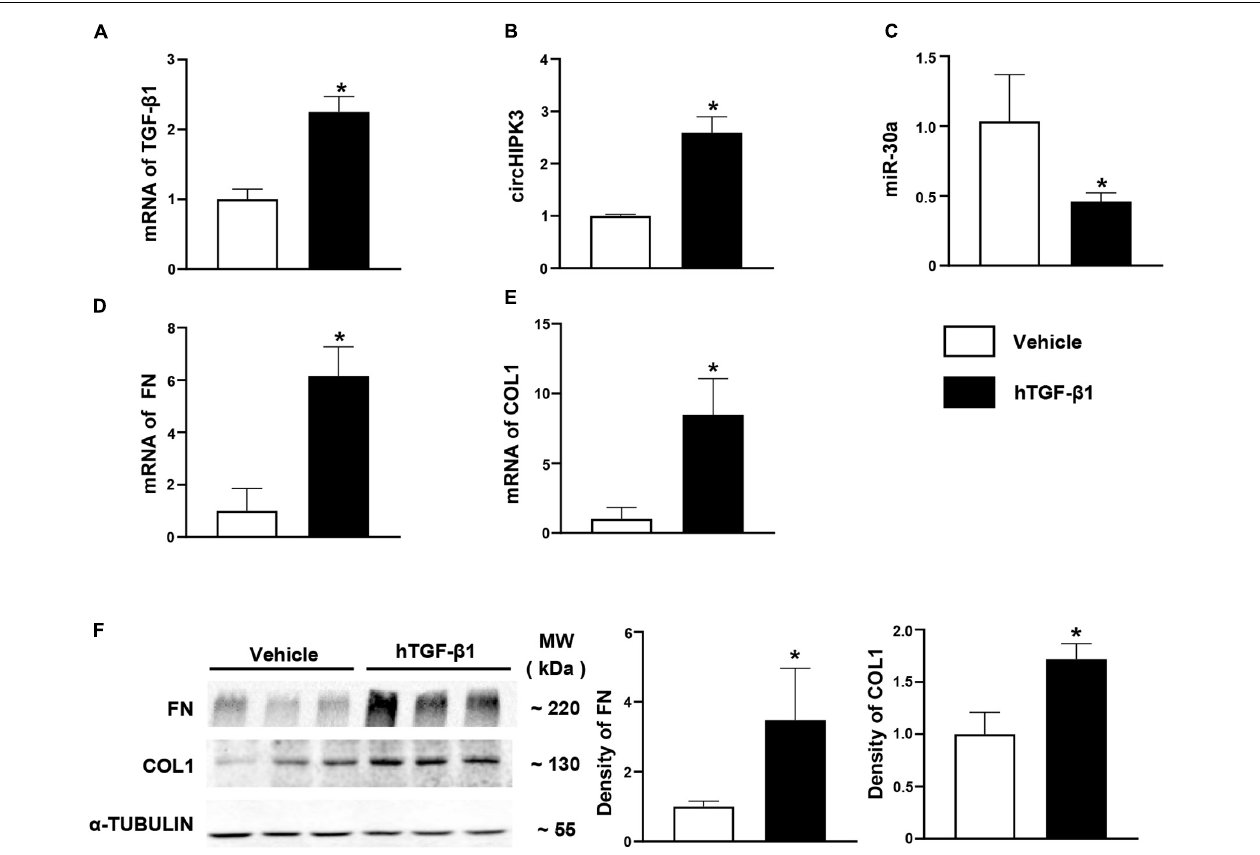
FIGURE 4 | Expression of circHIPK3/miR-30a/TGF- β 1 pathway in HK-2 cells with hTGF- β 1 treated. (A) mRNA levels of TGF- β 1 after hTGF- β 1 stimulation in HK-2 cells. (B–E) The levels of circHIPK3, miR-30a, FN, and COL1 on qPCR after hTGF- β 1 stimulation. (F) Protein levels of FN and COL1 on immunoblotting and semi-quantitative analysis after hTGF- β 1 stimulation. n = 6 in each group, * p < 0.05, hTGF- β 1 vs.